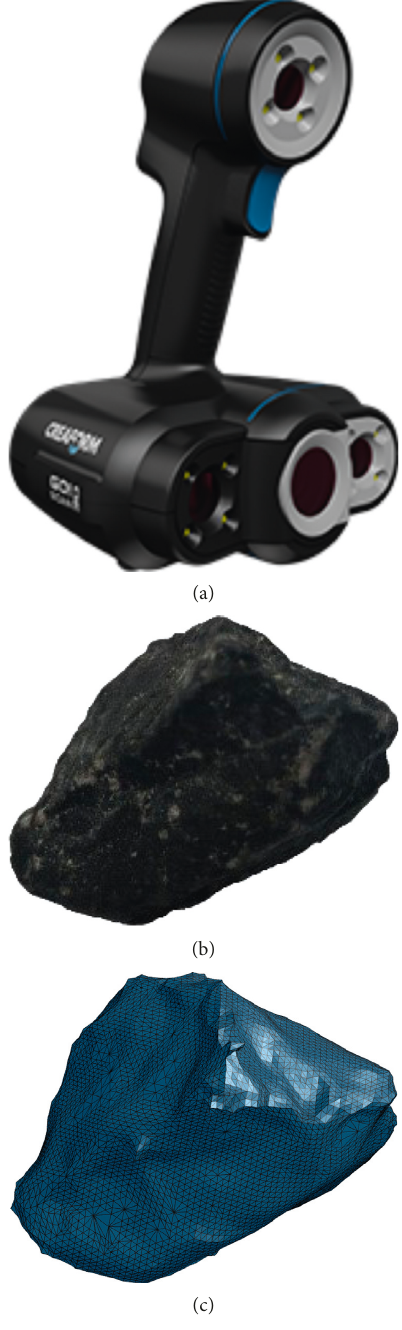
Figure 1: Actual aggregate laser scanning. (a) Creaform laser scanner. (b) Actual aggregate. (c) Reconstructed